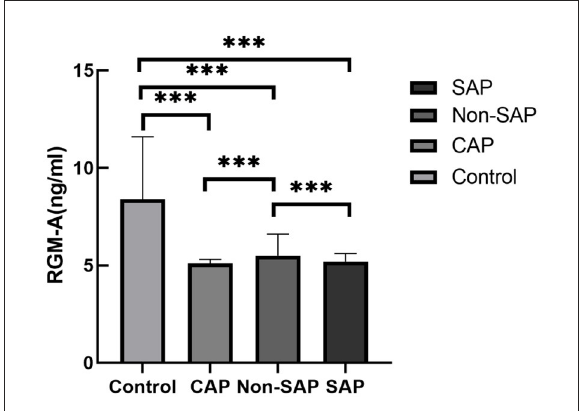
FIGURE2 Comparison of plasma RGM-A levels among the Control, CAP, Non-SAP, and SAP groups.RGM-A, repulsive guidance molecule A; CAP, community-acquired pneumonia; SAP, stroke-associated pneumonia. *** P <